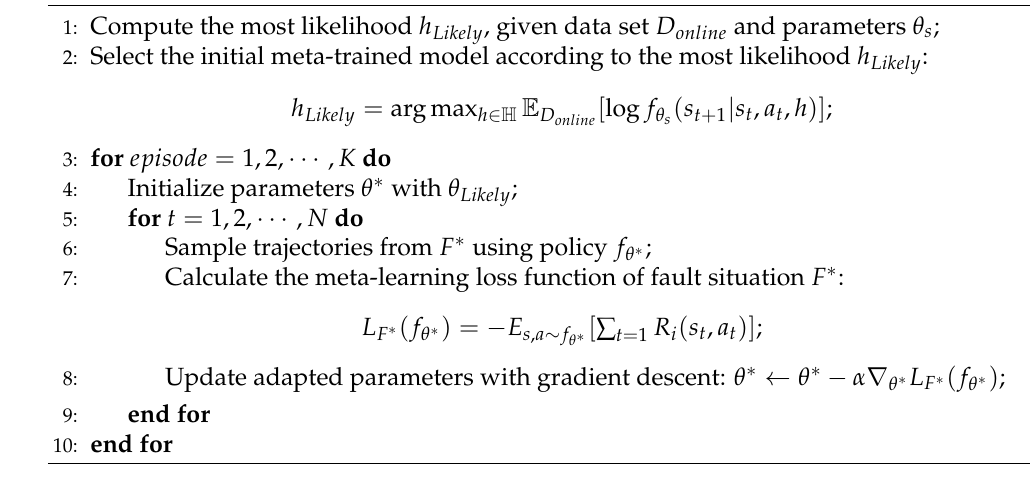
Algorithm 3 Update of the meta-trained